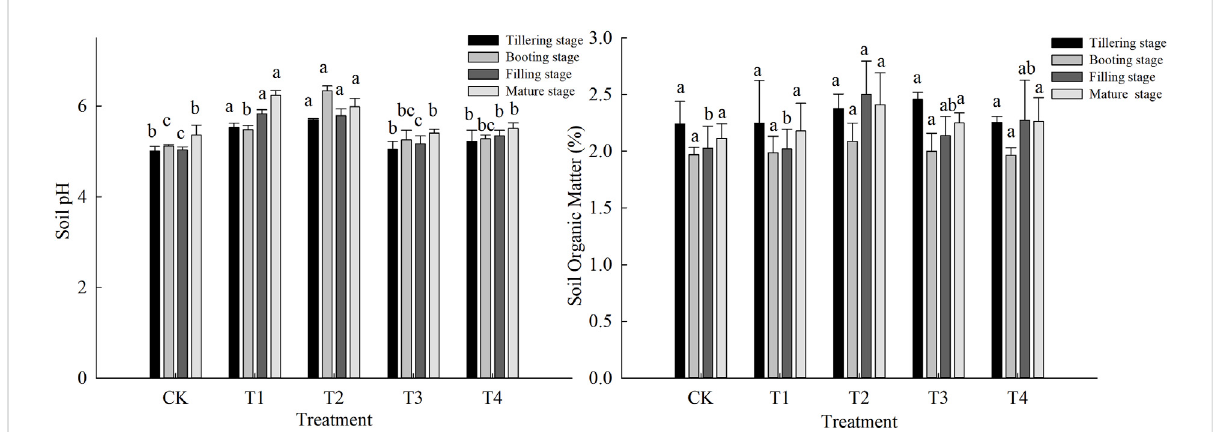
VariationinsoilpHandorganicmatteraftertheadditionofdifferentamountsofbiocharandbiochar-basedfertilizer.Datapointsanderrorbars represent mean ± S.D. of three replicates ( n = 3). Different letters indicate a signi fi cant difference between different treatments in the same period ( p <